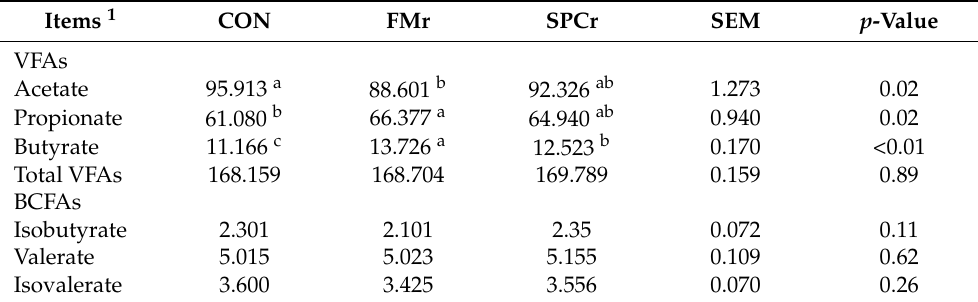
Table 8. Effects of replacing fishmeal and soybean protein concentrate with degossypolized cot- tonseed protein on concentrations of volatile fatty acids and branch-chain fatty acids in the cecum digesta ( µ